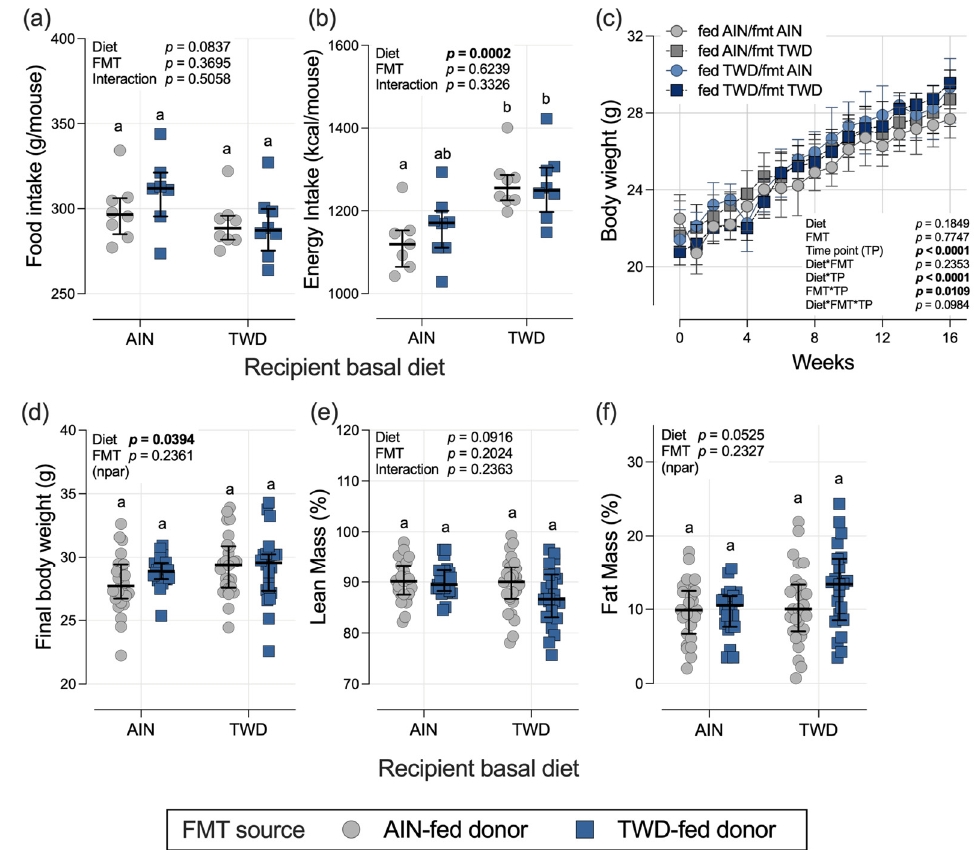
Figure 1. Food and energy intakes, body weight, and body composition. ( a , b ) Estimated total daily food and energy intakes per mouse per cage ( n = 7 to 8 cages per group). ( c ) Body weight gain over the study period ( n = 22 to 27 mice per group). ( d ) Final body weight at the study end point on day 112 ( n = 22 to 27 mice per group). ( e , f ) Lean and fat mass as percentage of body weight. ( n = 22 to 27 mice per group). The data are shown as individual measurements (except ( c )) with the median ± interquartile range ( a , b , d – f ). The inserted values show the statistical model’s main effects for recipient basal diet and FMT source, and their interaction, or “npar” if a non-parametric test was required, and different letters indicate that the experimental groups are significantly different ( p < 0.05), as determined by the statistical methods outlined in the Materials and Methods section.